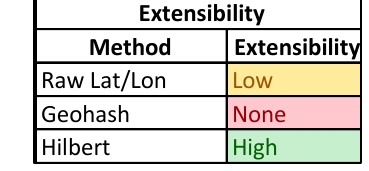
Table 5. Extensibility Comparison